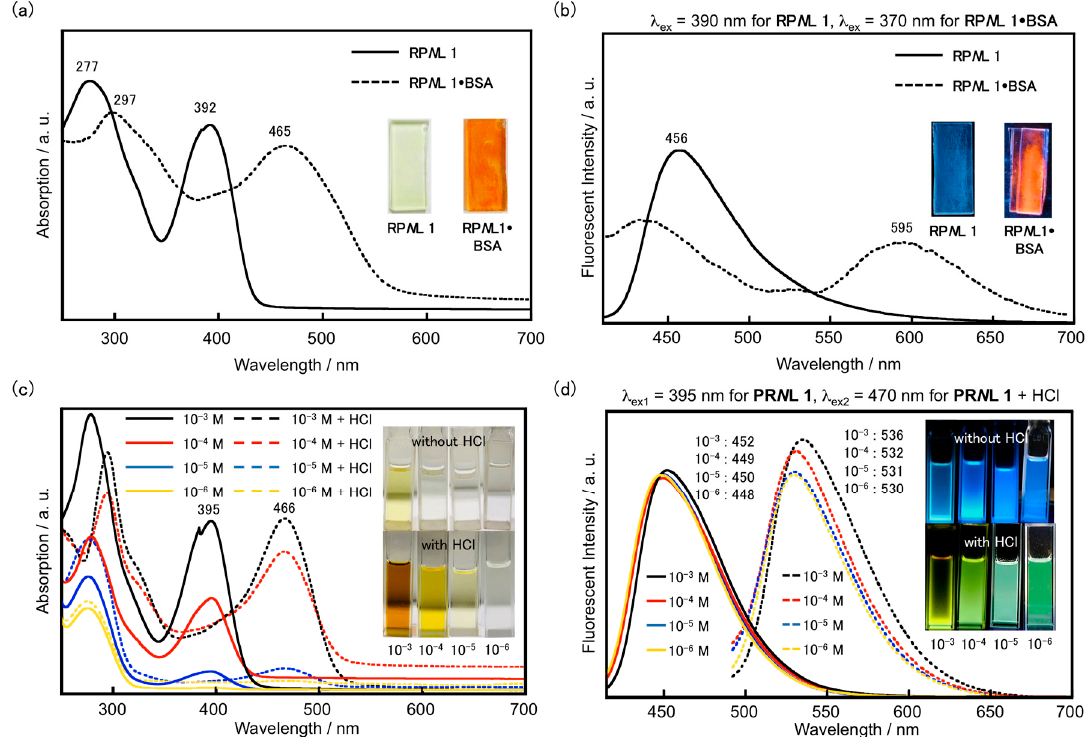
Figure 4. ( a ) UV-vis absorption spectra and ( b ) fluorescent spectra of RP N L 1 and RP N L 1·BSA. ( c ) UV-vis absorption spectra and ( d ) fluorescent spectra of RP N L 1 and RP N L 1 with HCl in CHCl 3